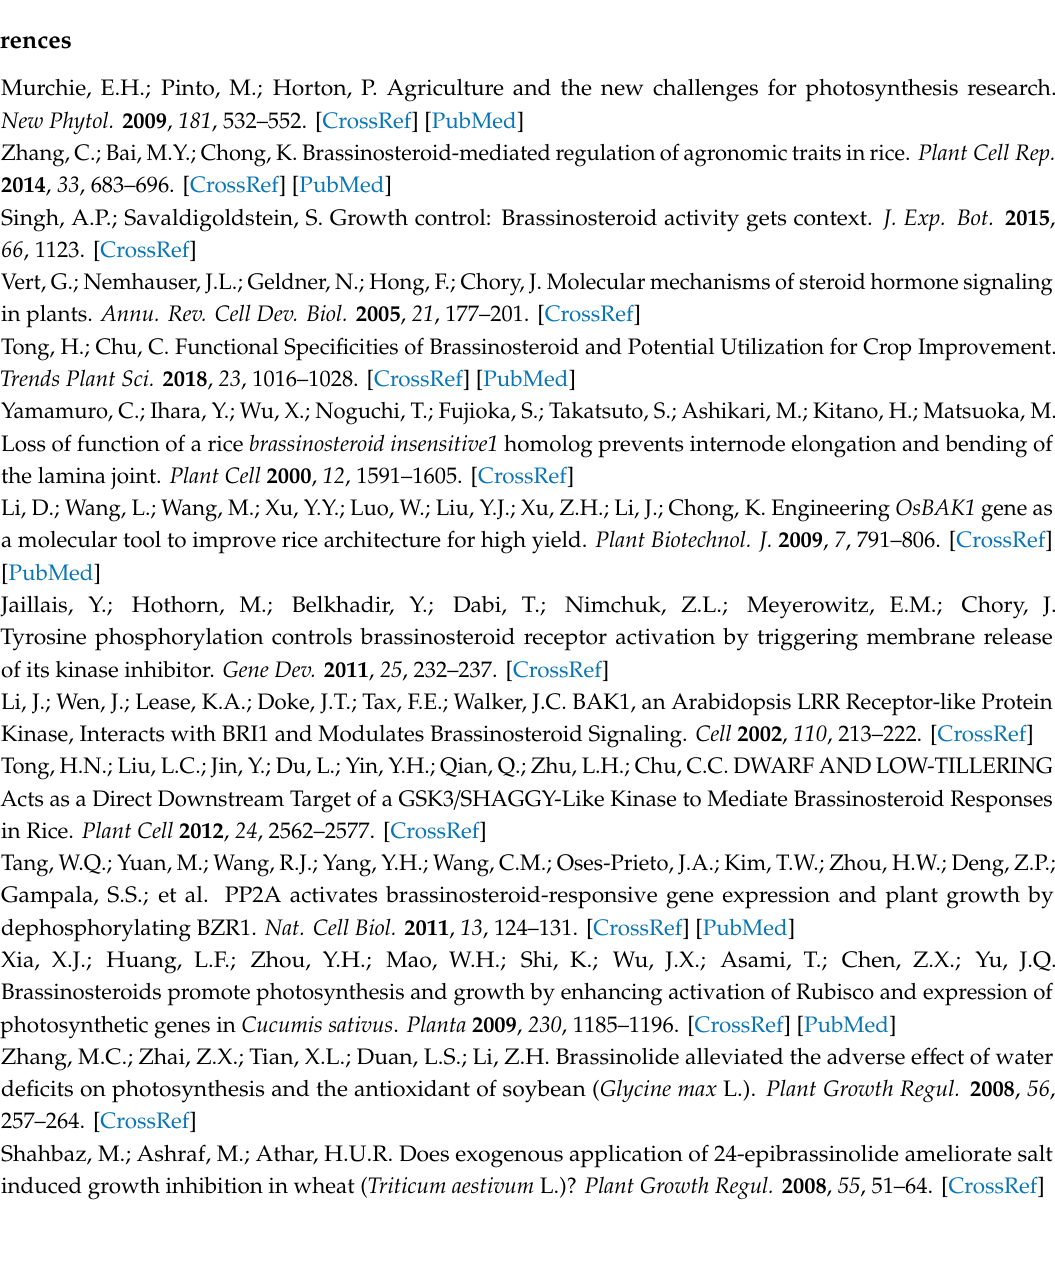
Figure S1: Multiple alignment of deduced amino acid sequence of TaBRI1 of A ( TaBRI1-A1 ), B ( TaBRI1-B1 ) and D ( TaBRI1-D1 ) genomes; Figure S2: The leaf angle in the wild type (WT), TaBRI1 mutants and corresponding BC 1 F 2 homozygous individuals for TaBRI1 deletion identified with TaBRI1-A1 and TaBRI1-D1 specific primers at 14 DPA; Figure S3: The root length of WT and TaBRI1 mutants at seedling stage; Figure S4: The yield traits in WT, TaBRI1 mutants; Figure S5: Photosynthesis parameters in WT and TaBRI1 mutants during the whole post-anthesis period; Table S1: Primers used in this